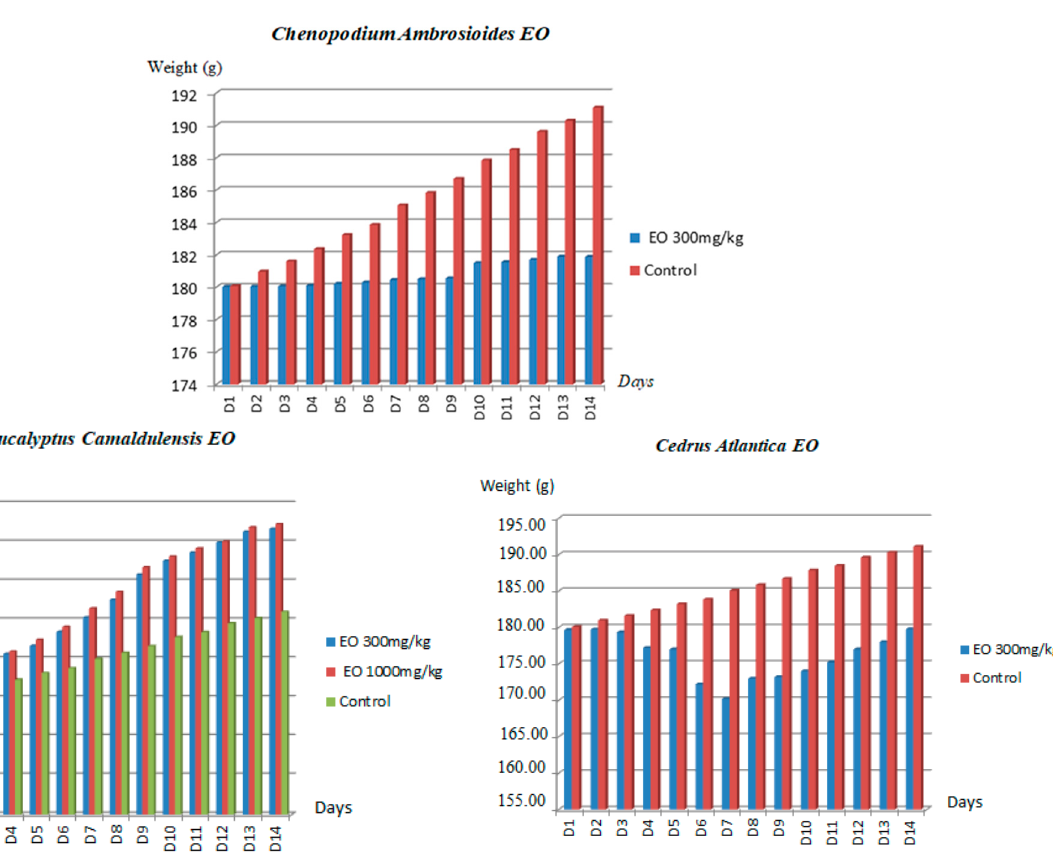
Table 5. Results of acute oral toxicity tests of oils with di ff erent doses. Essential Oils